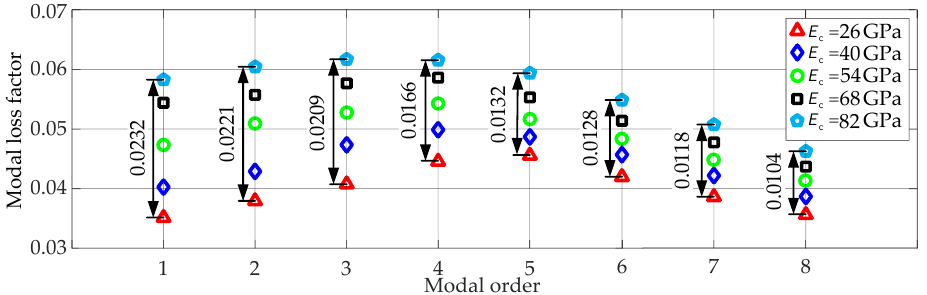
Figure 5. The modal loss factor of the composite shell corresponding to different elastic modulus of hard coating.